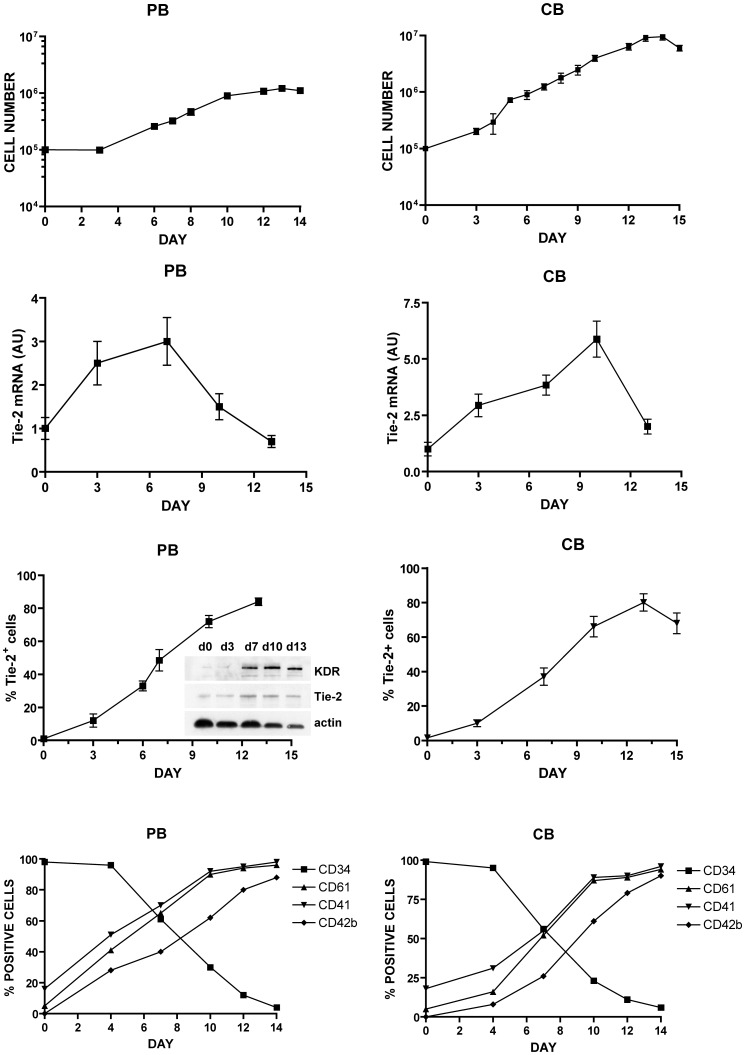
Tie-2 expression during Mk differentiation of cord blood or peripheral blood CD34+ cells.Kinetics of Tie-2 expression during TPO-driven megakaryocytic differentiation of cord blood (CB, Left Panels) or cord blood (PB, Right Panels) CD34+ cells. Purified CB or PB CD34+ cells have been grown in serum-free medium in the presence of TPO and, at various days of culture, cell aliquots have been harvested and and analyzed for cell growth (top panels), for Tie-2 expression at mRNA and protein level (mean percentage of positive cells ± SEM observed in three separate experiments, middle panels) and for the expression of membrane differentiation markers CD34, CD41, CD61 and CD42b (bottom panels). In the inset the Tie-2 WB analysis on Mks grown from PB is reported. Mean values ± SEM observed in three separate experiments.